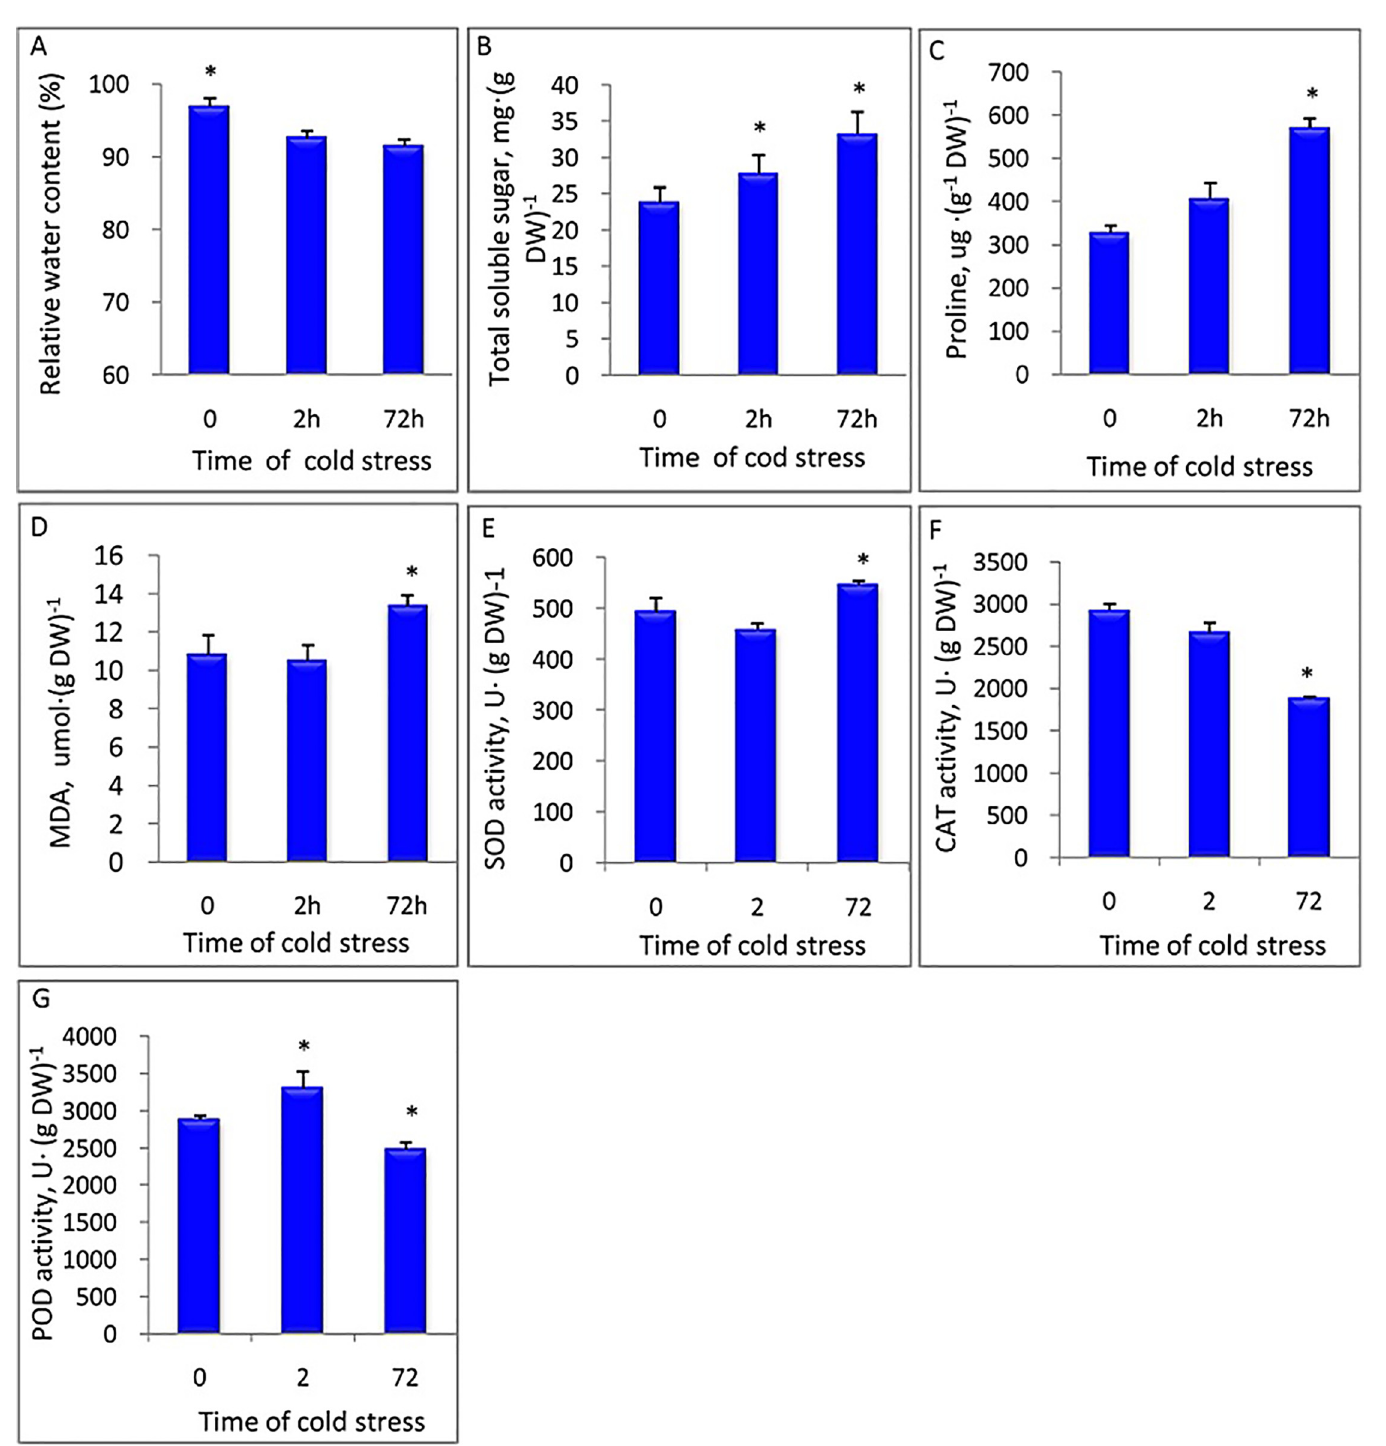
Fig 1. Physiological change in leaves under cold stress. ‘ Meyer ’ was placed in growth chambers at 4°C for the cold treatment and at 25°C for the control. The second expanded leaf from the top was used for determinations. Experiments were conducted with five biological replicates, and results were expressed as mean ± standard error (SE). * P <